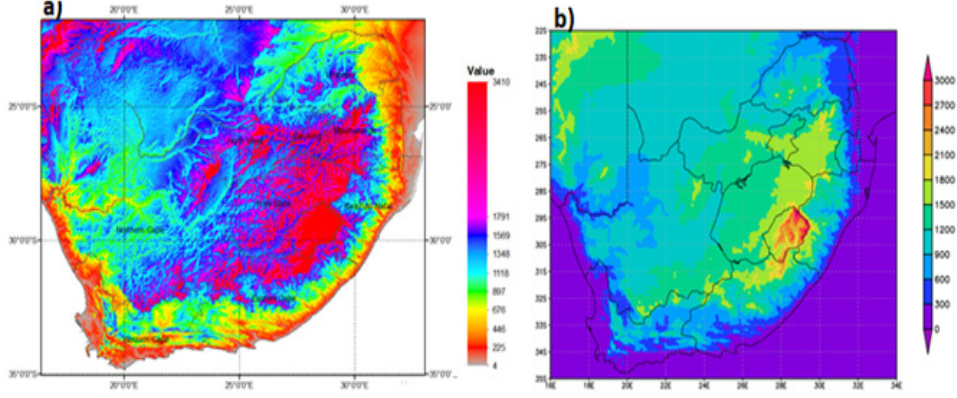
Figure 1. The Shuttle Radar Topography Mission (SRTM) from NASA ( a ) vs. Unified Model (UM) topography ( b ) (in meters) over South Africa .